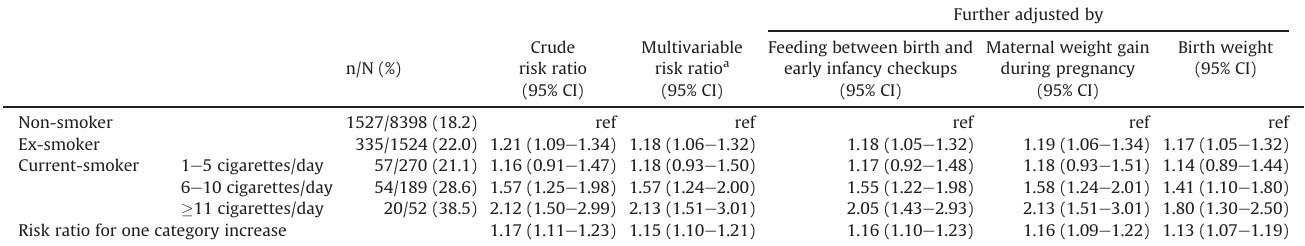
Table 3 Risk ratios of rapid weight gain at early infancy by maternal smoking during pregnancy, With calculated weight z-scores at birth adjusted for sex and gestational age.